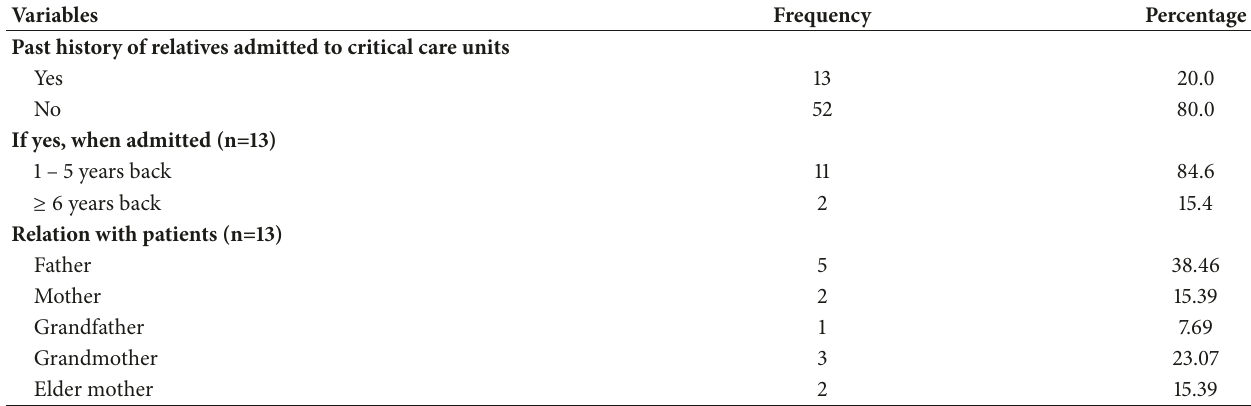
Table 2: Past history of nurses’ relatives admitted to critical care units.